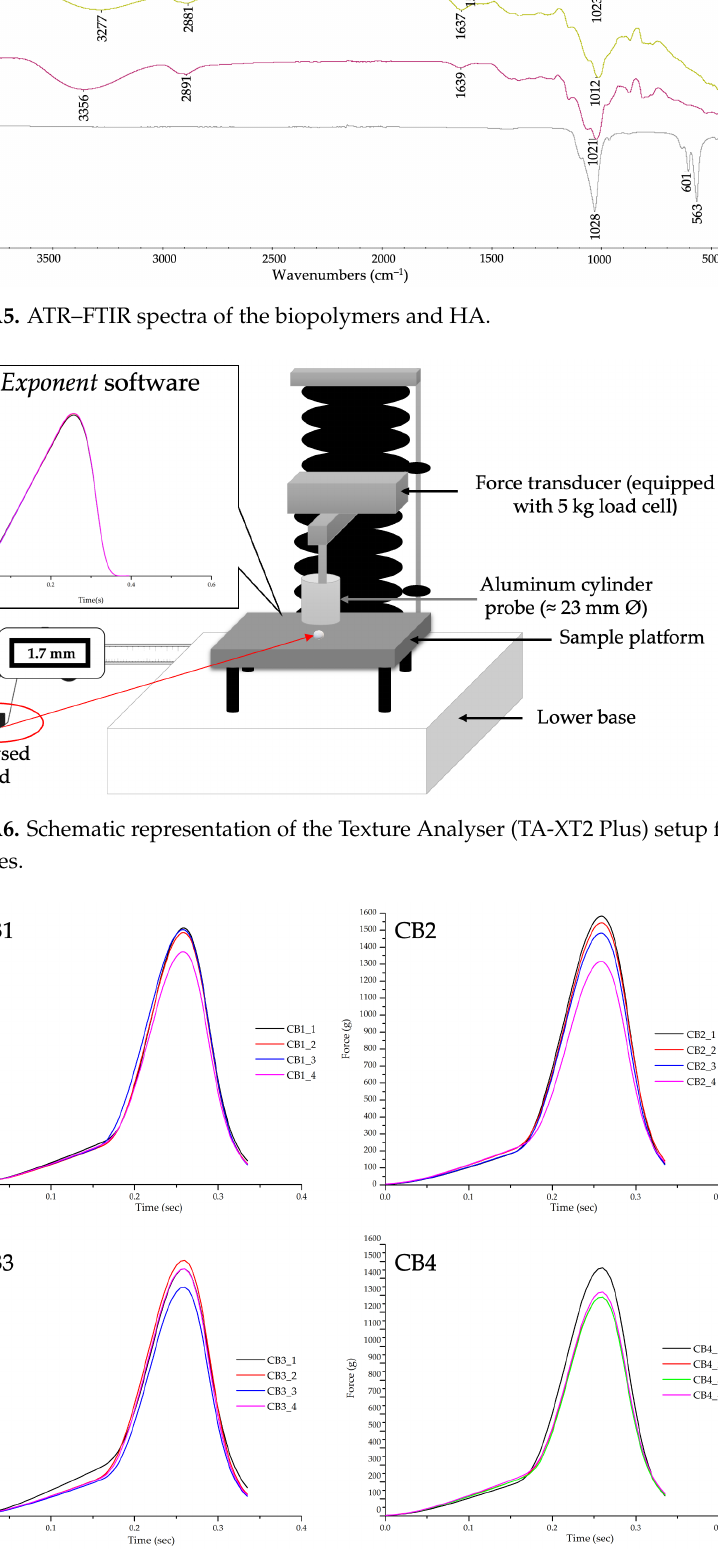
Figure A7. The results of the mechanical assay, displayed by the device used (TA-XT2 Plus) for the prepared beads .